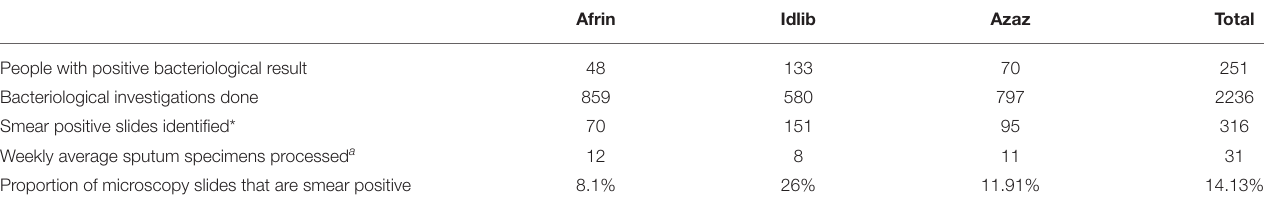
TABLE 1 | Results of bacteriological investigations, cumulative and disaggregated by cities in Northwest Syria. Afrin Idlib Azaz Total People with positive bacteriological result